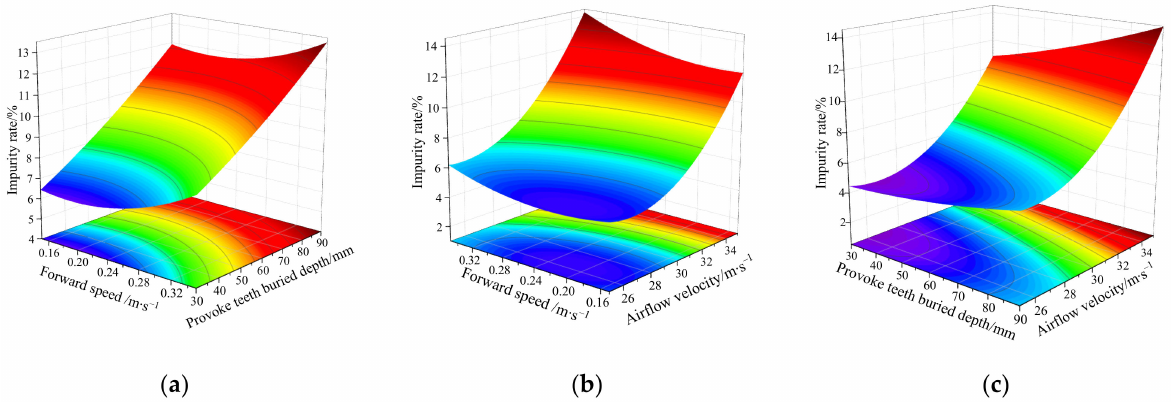
Figure 8. Interaction factors’ effect on the impurities rate: ( a ) interaction factors between the forward speed and the provoke teeth buried depth, ( b ) interaction factors between the forward speed and the airflow velocity, and ( c ) interaction factors between the provoke teeth buried depth and the airflow velocity.